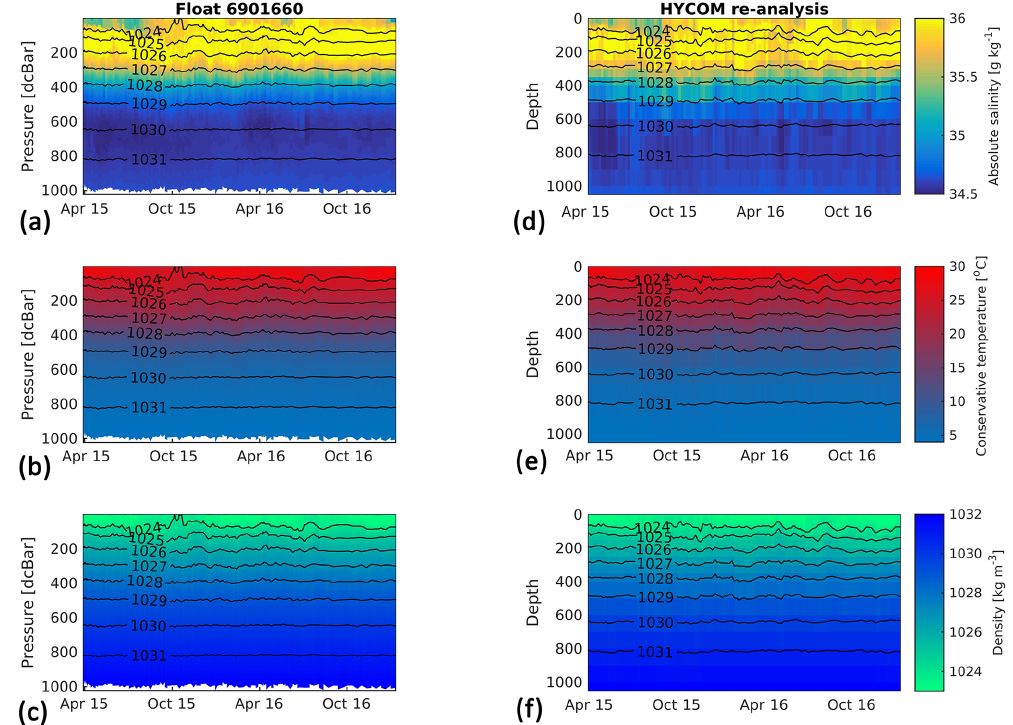
Figure C2. Profiles of (left side) float 660 and (right side) corresponding data from the HYCOM re-analysis over depth and time for (a, e) absolute salinity, (b, f) conservative temperature and (c, g) density. Every colored point corresponds to a measurement. The black lines indicate the isopycnals from 1024 to 1031kgm − 3